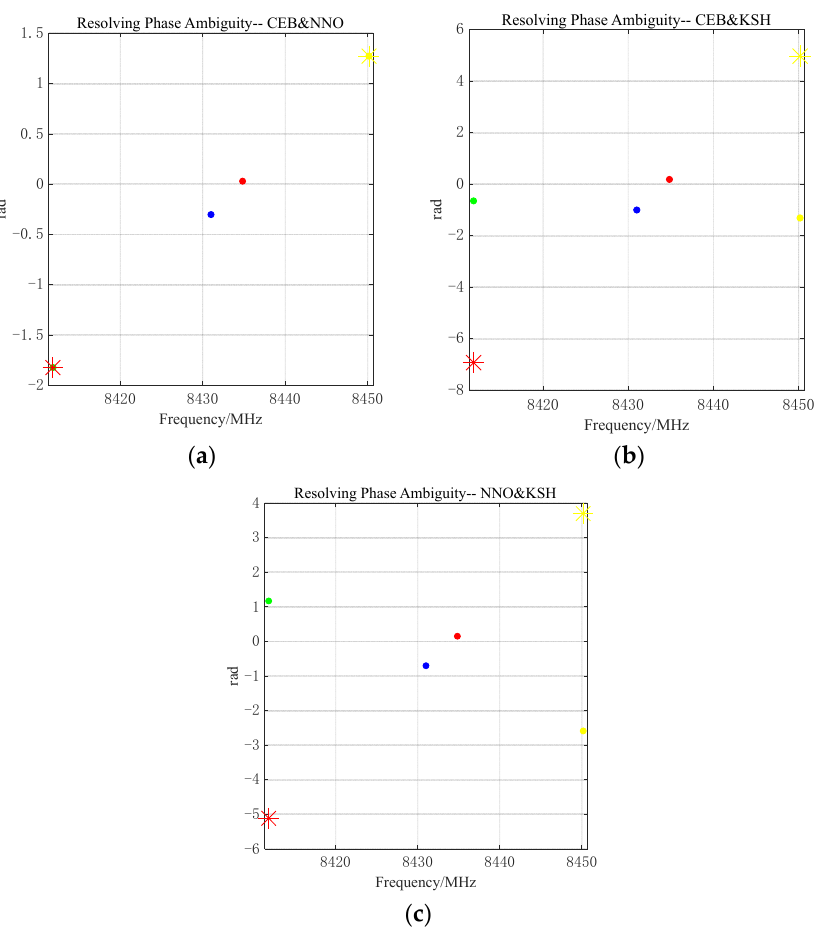
Figure 10. Resolving phase ambiguity of DOR Tones, dot point means original phase, star point means ambiguity resolved phase, color blue represents carrier, red +1DOR, green − 2DOR, yellow +2DOR: ( a ) Baseline CEB ‐ NNO; ( b ) Baseline CEB ‐ KSH. ( c ) Baseline NNO ‐ KSH.